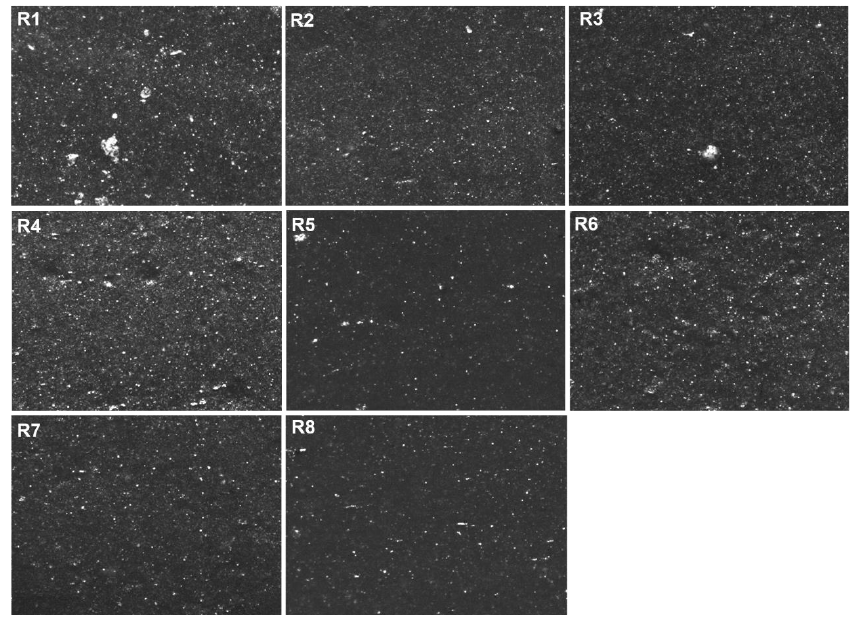
Figure 8. Dispergrader images of the SBR/silica compounds. Table 3. Dispersion and average cluster size of the studied compounds.